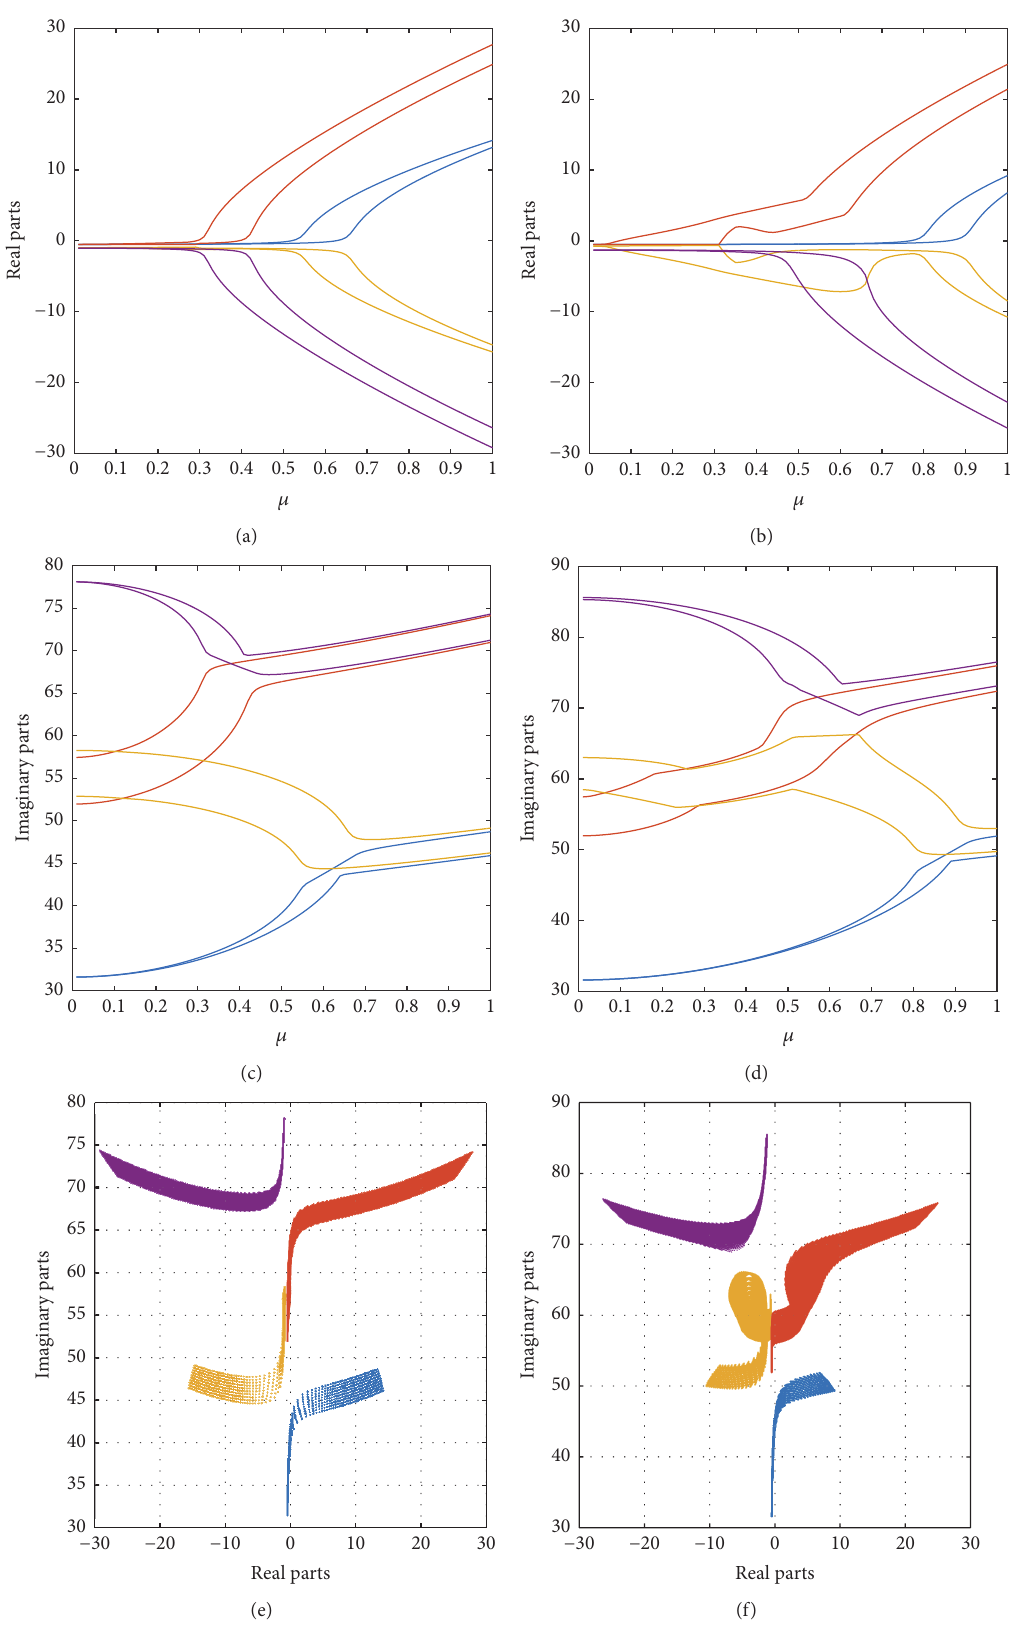
Figure 5: Three-dimensional parameter space: real (a, b) and imaginary (c, d) parts of eigenvalues versus 𝜇 and evolution in the complex plan (e, f) for configurations 1 (a, c, e) and 2 (b, d,